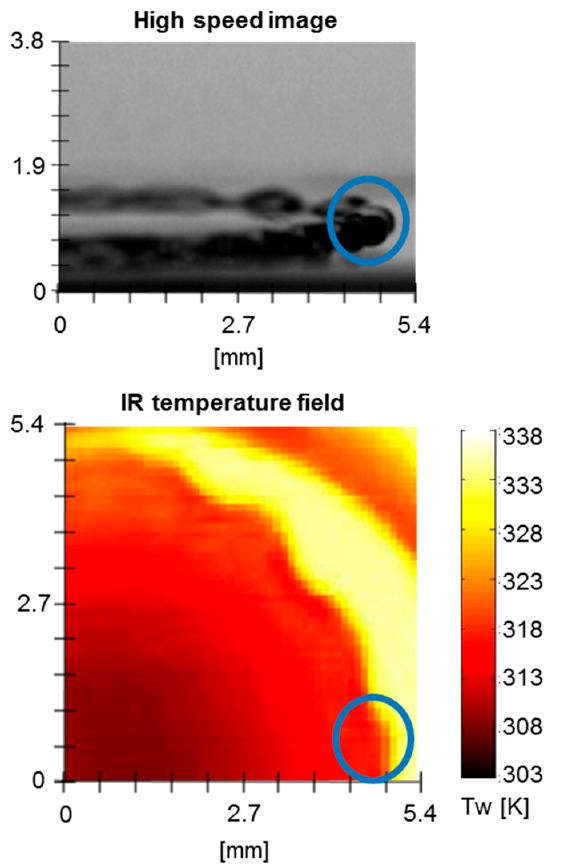
Figure 8. Example of lamella fingering as captured in the high speed recorded images and in the correspondent IR thermography images, taken from the bottom of the heated stainless steel foil. The blue circle highlights the region where fingering is observed. The reported images refer to We = 151, Tw (in) = 333.15 K and were taken at a time after impact t = 4 ms.